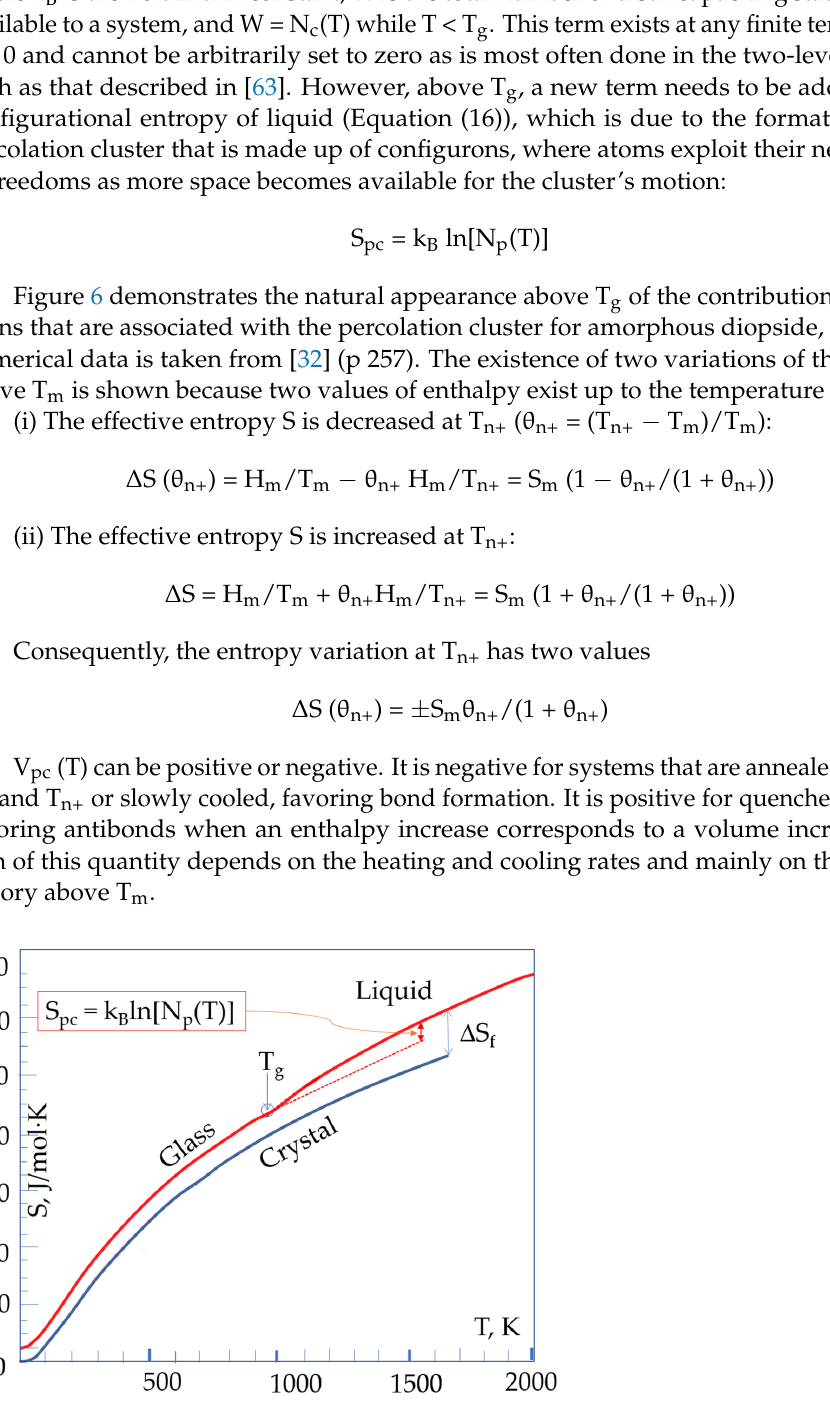
tropy, which show a kink at the T tr , while the second derivative of the chemical potential and heat capacity change discontinuously. In line with the Landau theory of second-order phase transformations, they occur when a new state of reduced symmetry develops con- tinuously from the more disordered phase, which is typically at the higher temperature. He observed that near a phase transition, an approximate form for the free energy can be constructed with an order parameter that is zero before the transition and nonzero after the phase transition [79]. Examples of second-order transitions include the ferromagnetic– paramagnetic transition, where the magnetization is the order parameter and the struc- tural phase transition from a cubic phase to a tetragonal phase occurs, where the order parameter is the parameter (c/a − 1), where c is the length of the long side of the tetragonal unit cell and a is the length of the short side of the tetragonal unit cell. For second-order phase transitions, the order parameter increases continuously from zero, starting at the T tr . As we see from Equation (9) and Figure 2, the transition of a glass to a liquid at T g exactly follows the universal case of second-order phase transformation, although it oc- curs in the metastable phases as both a glass and a supercooled liquid are not thermody- namically equilibrium states of matter. Due to the formation of the configuron phase, the specific heat capacity of amorphous materials at the transition follows the universal law: C pc (T) = C 0 /|T − T g | 1 −β (21) where C 0 is a coefficient that accounts for the contribution of the configuron phase. As (1 − β ) = 0.59, the heat capacity contribution from the formation of configuron phase diverges